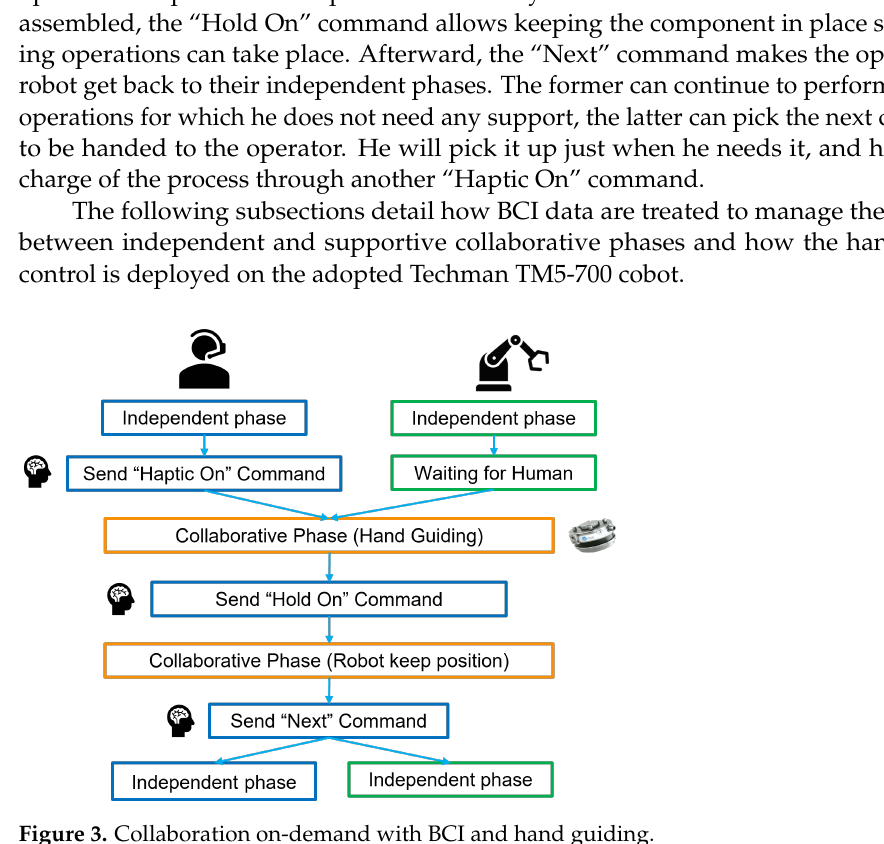
Figure 3. Collaboration on-demand with BCI and hand